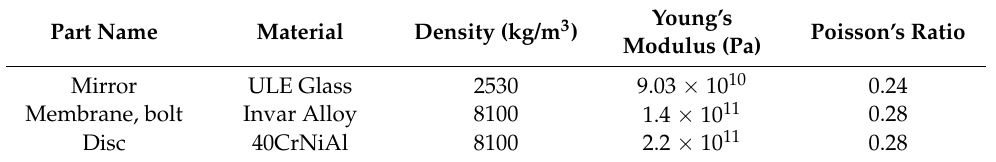
Table 2. Material properties.